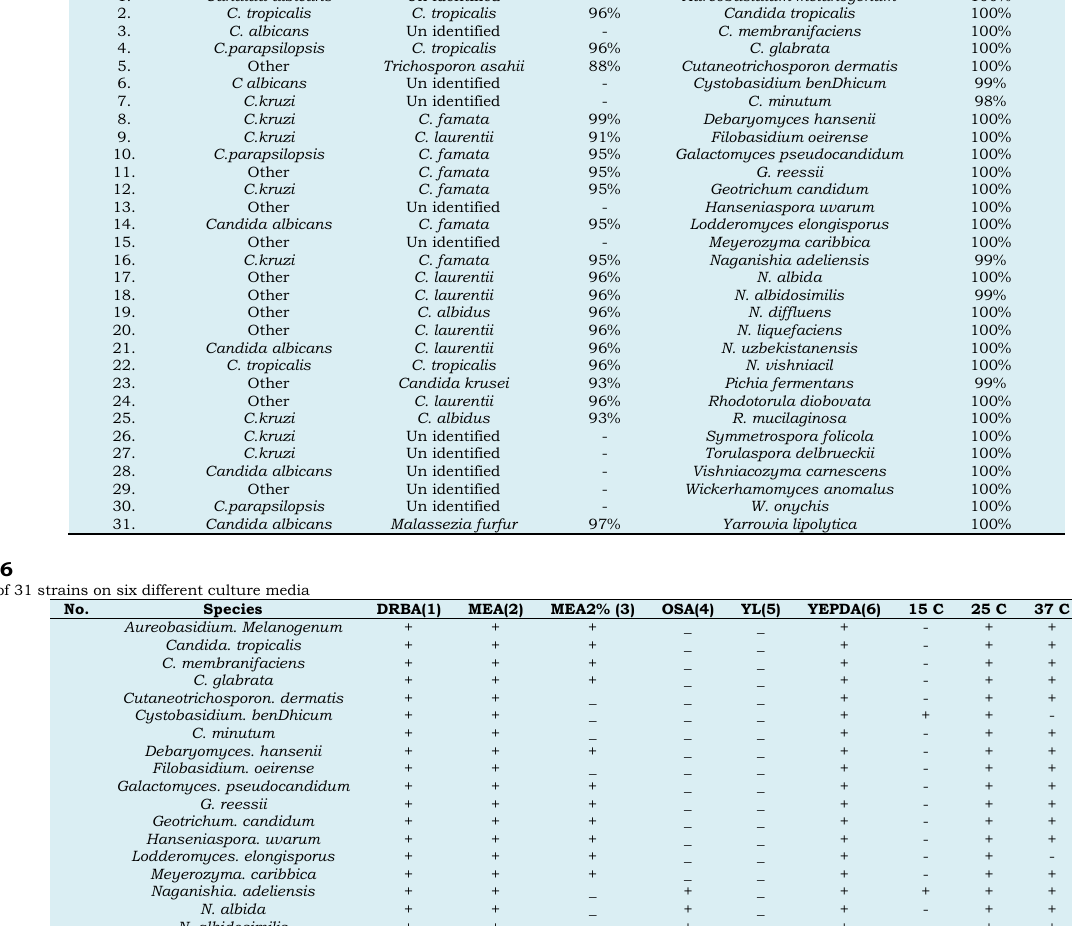
Table 5 Phenotypic, biochemical and molecular identification of yeast Isolate No.